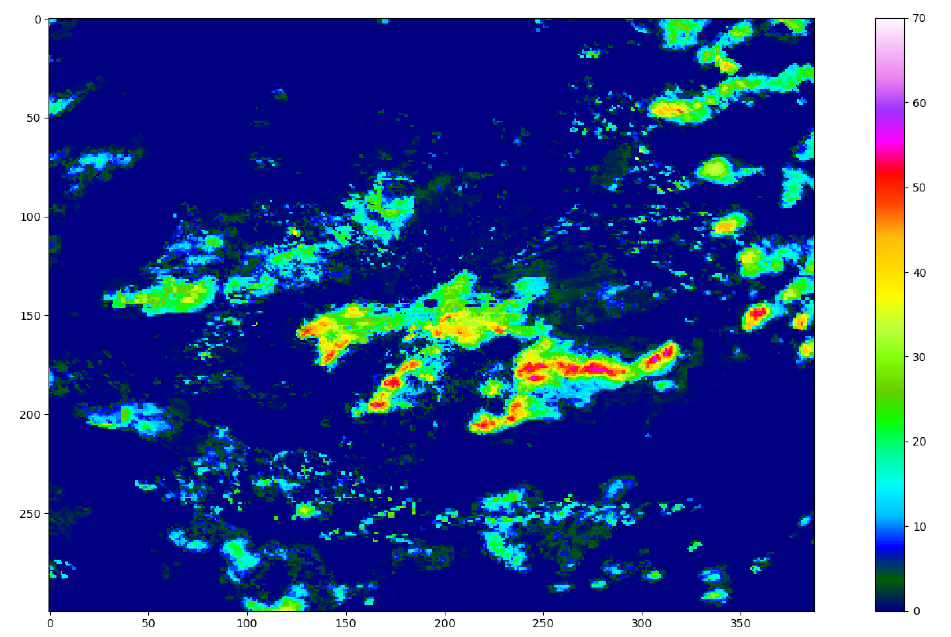
Figure 11. Predicted data, using the model trained on uncleaned data, for product R 01 (reflectivity at the lowest elevation angle, measured in dBZ with values ranging form 0 to 70) at 14:37:22